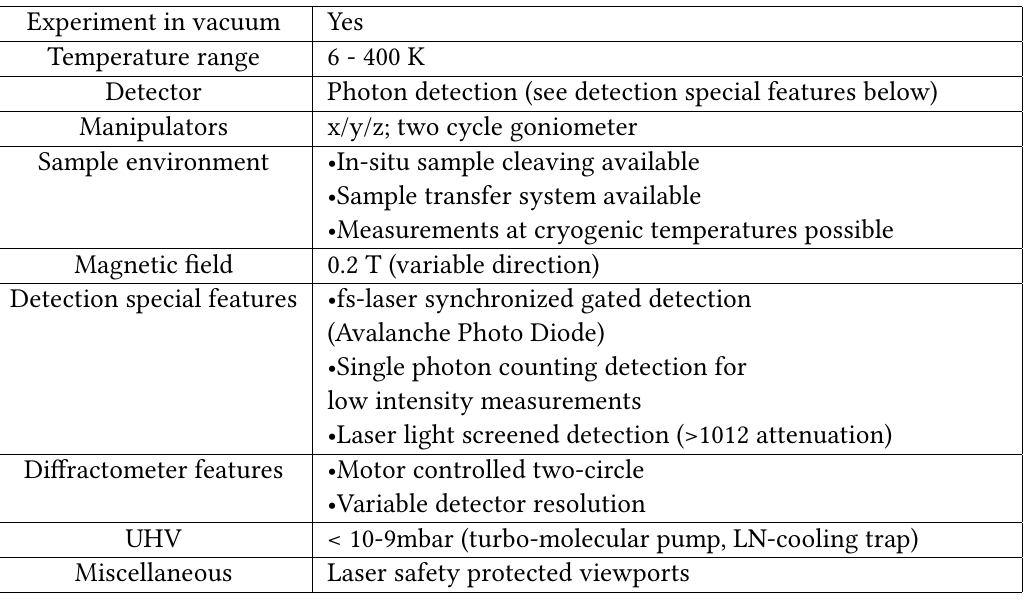
Table 4: Technical parameters FEMTOSPEX Scattering